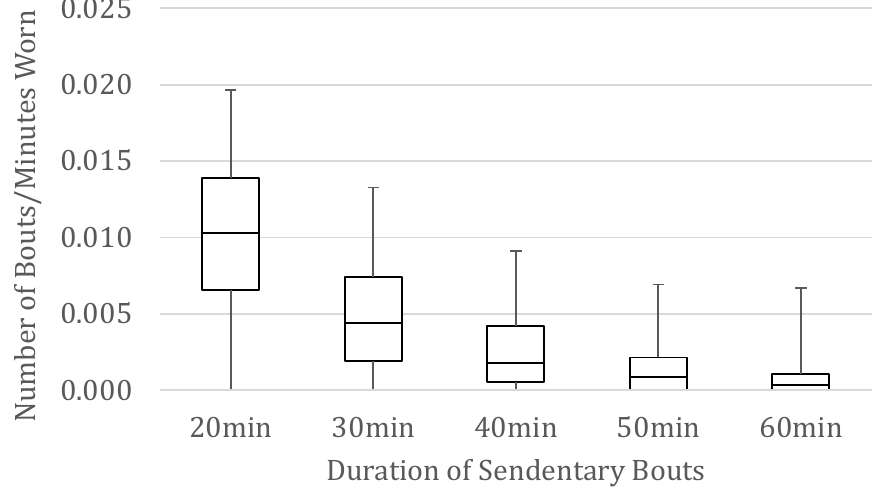
Figure 1. Box and whisker plots of the number of bouts of uninterrupted sitting 20–60 min per minute that the device was worn.